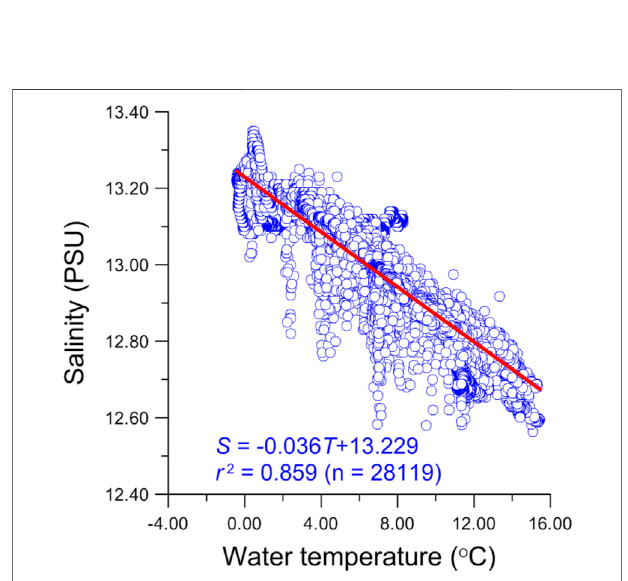
FIGURE 3 | Linear relationship between water temperature and salinity in Lake Qinghai during July 2010 through September 2012.